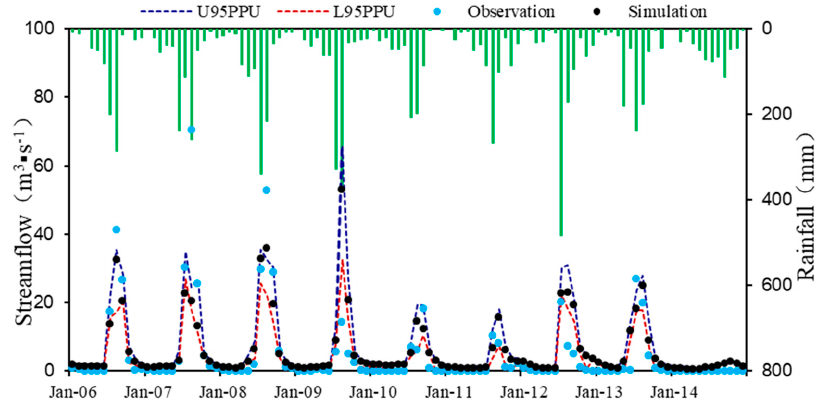
Figure 9. Runoff simulation of the Xinxue River basin in calibration and validation periods 95PPU based on GLUE.